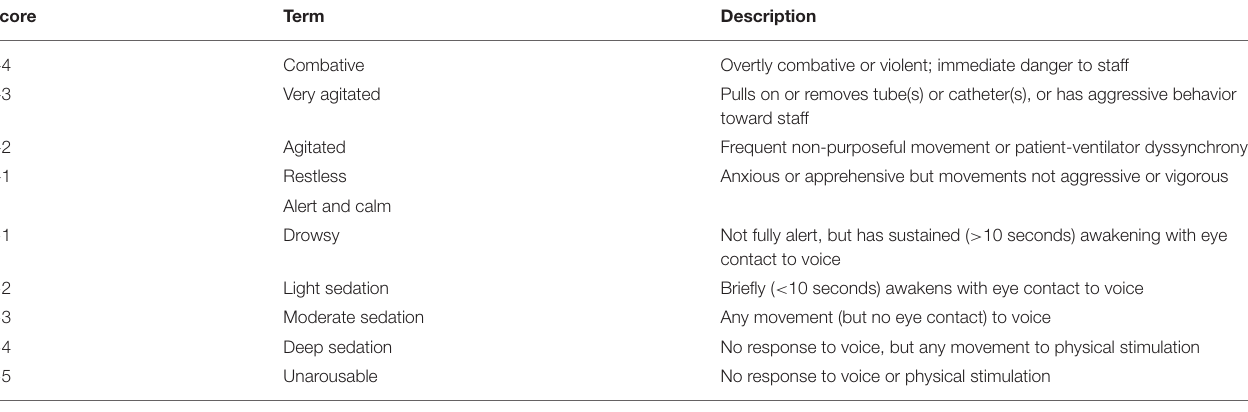
TABLE 2 | The critical-care pain observation tool (CPOT).